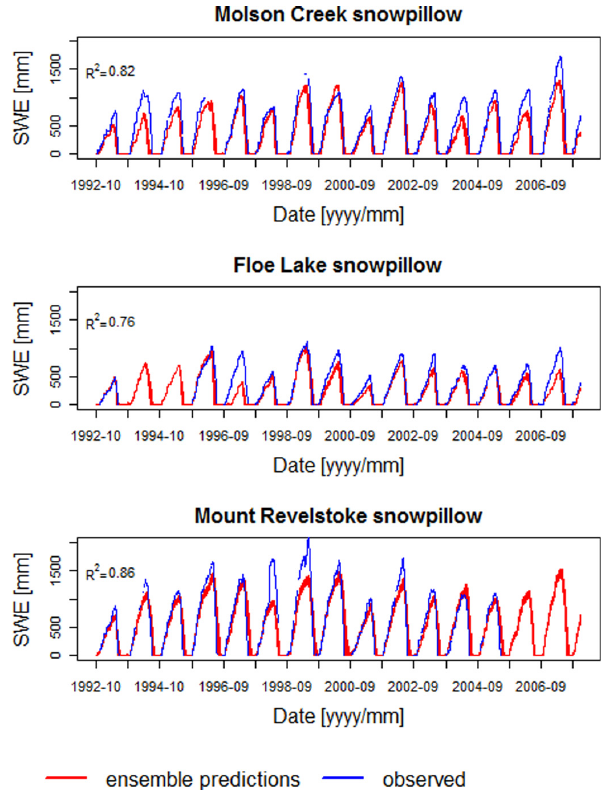
Fig. 5. Ensemble simulated and observed snow water equivalents for three snow pillow sites. Simulations are for the GRU that cor- responded to the snow pillow sites, and show the 5–95% quantile range.